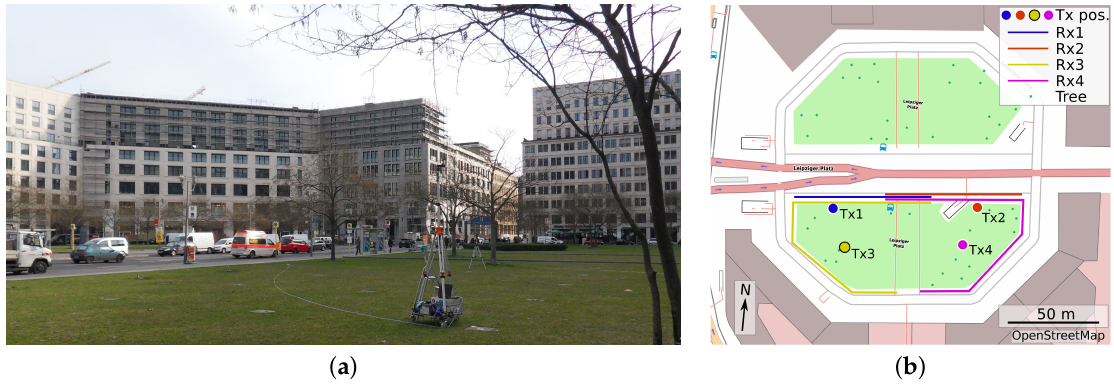
Figure 1. Measurement environment “open square, city center” (OS-CC): ( a ) photo with transmitter (TX) pole at position Tx3 and ( b ) map with TX positions and receiver (RX)